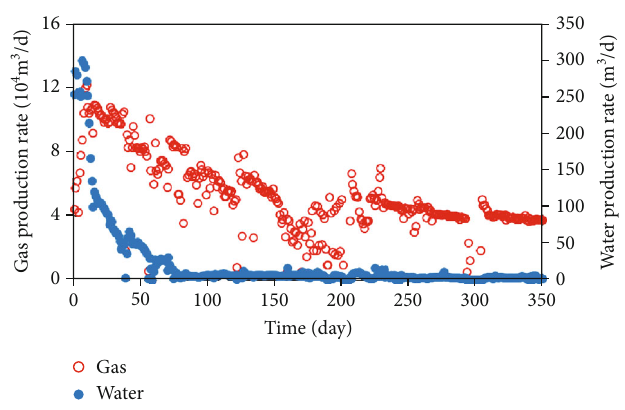
Figure 4: Production performance curve of multistage fractured horizontal well in a shale gas reservoir. Table 1: Basic parameters of multistaged fractured horizontal well in a shale gas reservoir.